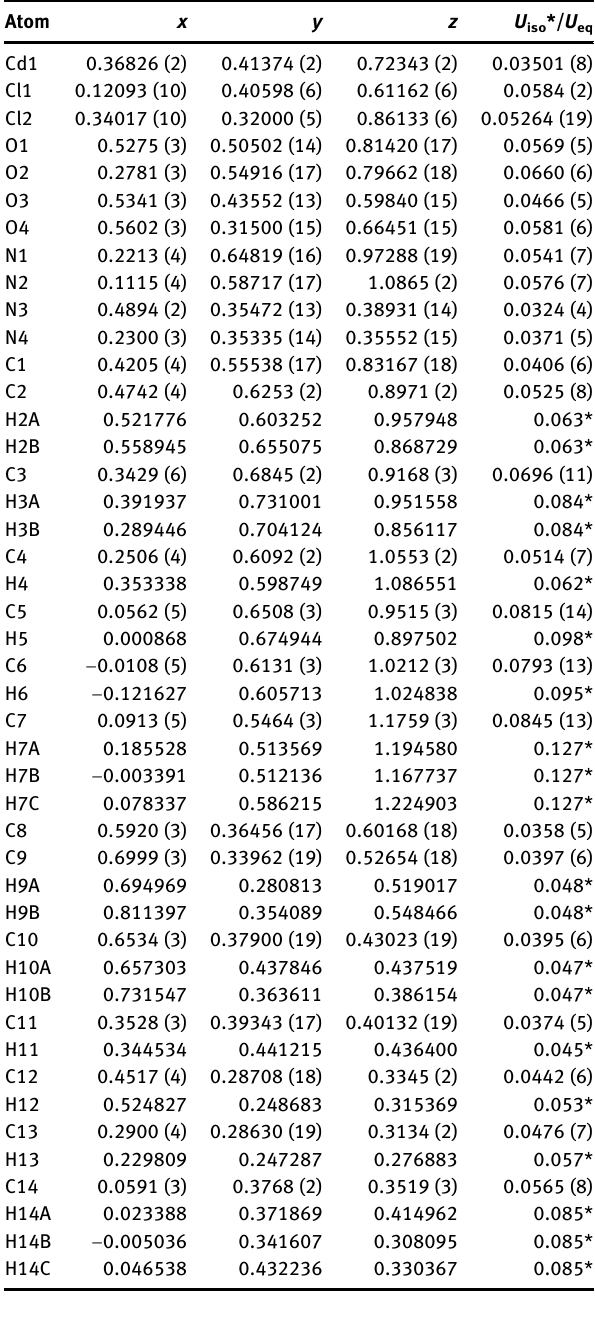
Table  : Fractional atomic coordinates and isotropic or equivalent isotropic displacement parameters (Å 